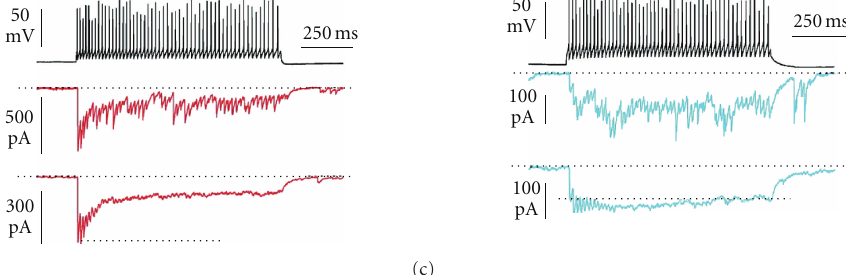
Figure 2: Example of diverse functional classes of inhibitory interneurons. (a) Single-neuron reconstructions of three di ff erent interneuron types of the neocortex: a basket cell (left), an axo-axonic cell (middle), and a dendrite-targeting Martinotti cell (right). Axons and somatodendritic compartments are shown in red and black respectively. Modified with permission from [51]. (b) Exampled of similar classes of GABAergic interneurons as in a, but in the hippocampus. modified with permission from [11]. (c) Di ff erent hippocampal interneuron classes show distinct properties of synaptic transmission. Examples of depressing (red traces) and facilitating (blue traces) unitary GABAergic responses originating from perisomatic and dendrite-targeting interneurons respectively. The upper red and blue traces are single-trial responses, whereas the bottom traces are averaged of multiple trials. Modified with permission from